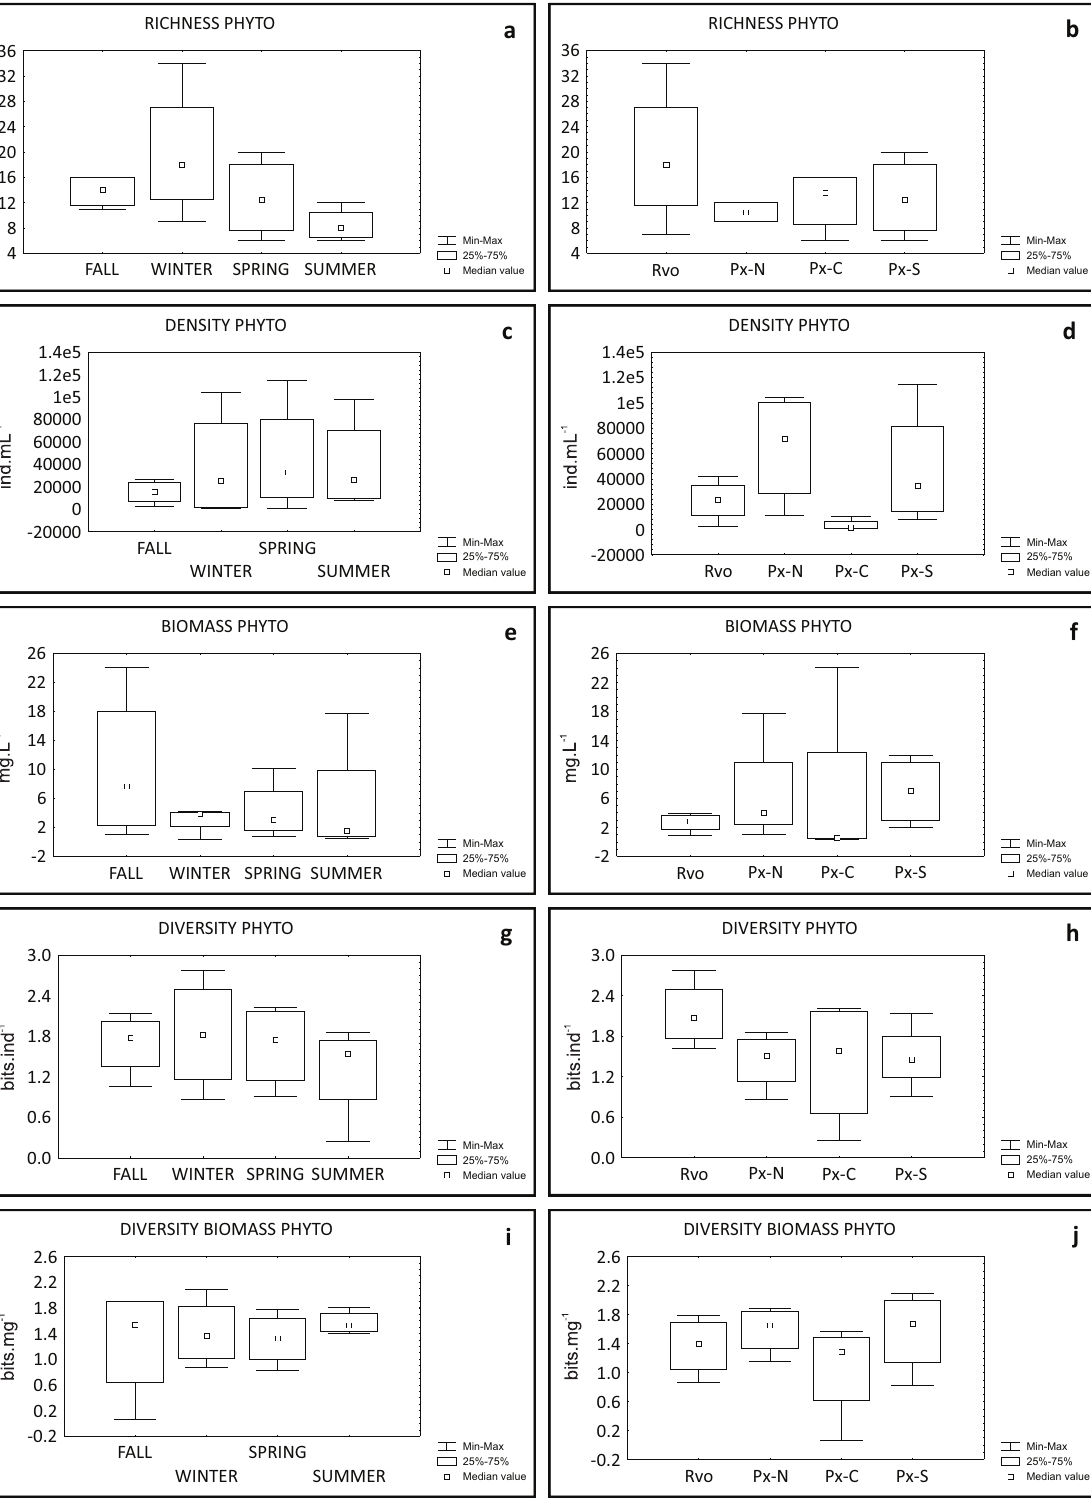
Figure 4 - Structure of phytoplankton communities in the Ruivo and Peixe lagoons with regard to seasonal (left) and spatial (right) distribution. (Legend for locations see Table